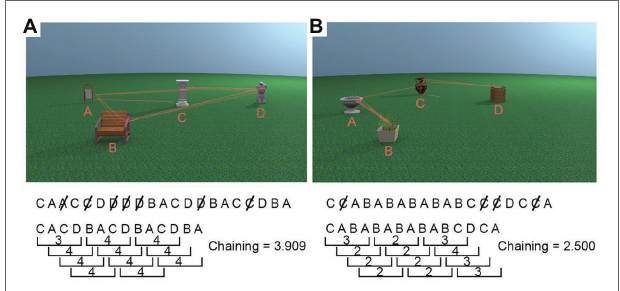
FIGURE 3 | Example chaining calculations. First, duplicates were removed from the sequence of objects gazed at, and then the number of unique objects in every window of four for the whole trial was averaged to produce the chaining measure. (A) A high chaining trial in which participants’ gaze was repeatedly directed towards objects which were not recently looked at. (B) A low chaining trial in which participants’ gaze moved back and forth between the same two objects for a large portion of the